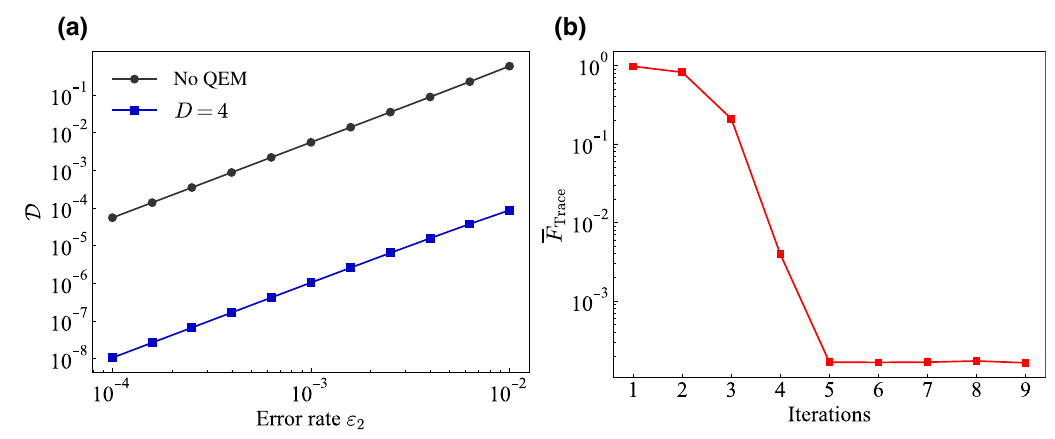
◦ U , 1 ) for different error rates. We benchmark D ( U , U ( 0 ) ) for the PEPO